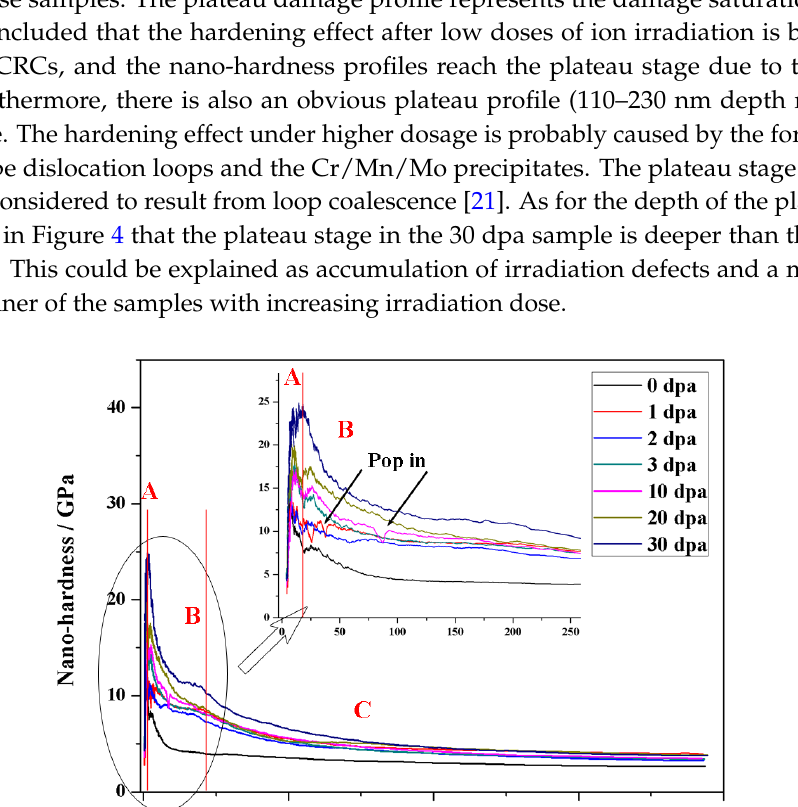
Figure 3. Microstructure of samples after different ion-irradiation doses, ( a ) 3 dpa; ( b ) 10 dpa; ( c ) 20 dpa; and ( d ) 30 dpa.